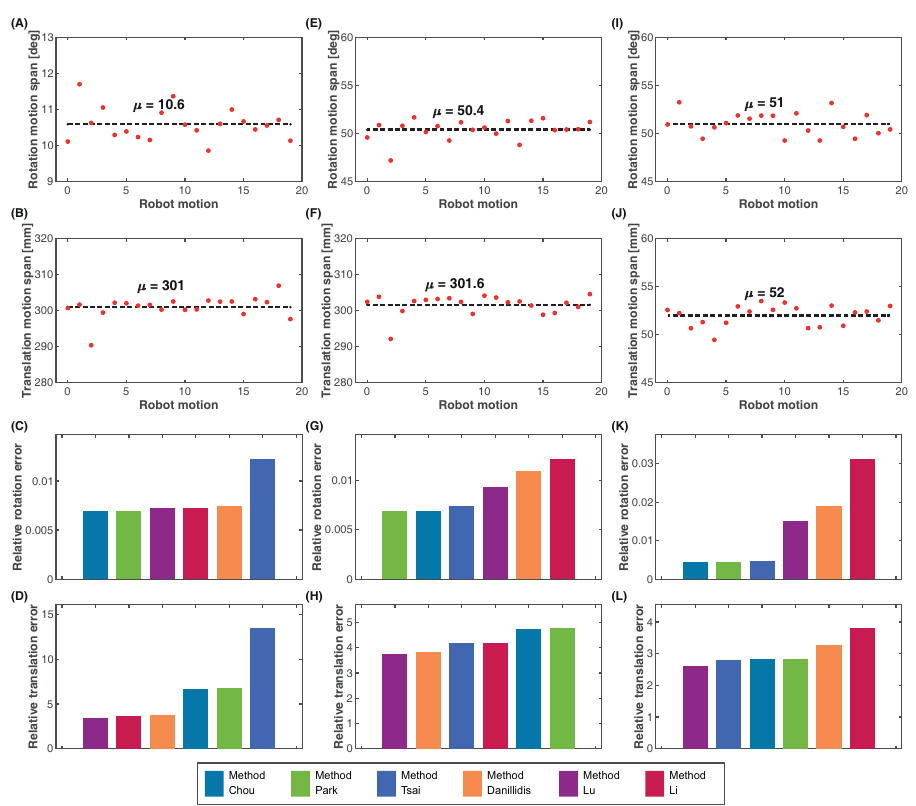
Fig 9. Motion range experiment. Experiment 1. Low rotation and high translation motion span. (A) Rotation motion span, mean μ = 10.6 deg. (B) Translation motion span, mean μ = 301.0 mm. (C) Rotation estimates. (D) Translation estimates. Experiment 2: High rotation and high translation motion span. (E) Rotation motion span, mean μ = 50.4 deg. (F) Translation motion span, mean μ = 301.6 mm. (G) Rotation estimates. (H) Translation estimates. Experiment 3: High rotation, low translation motion span. (I) Rotation motion span, mean μ = 51.0 deg. (J) Translation motion span, mean μ = 52.0 mm. (K) Rotation estimates. (L) Translation estimates.